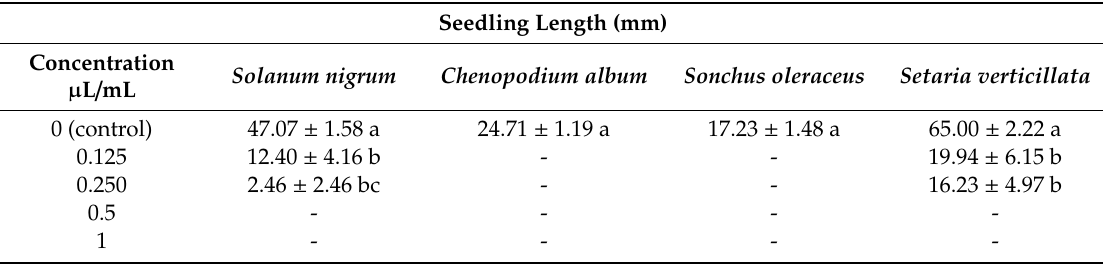
Table 4. Phytotoxic e ff ects of Thymbra capitata EO (TC3) on Solanum nigrum , Chenopodium album , Sonchus oleraceus and Setaria verticillata seedling length.